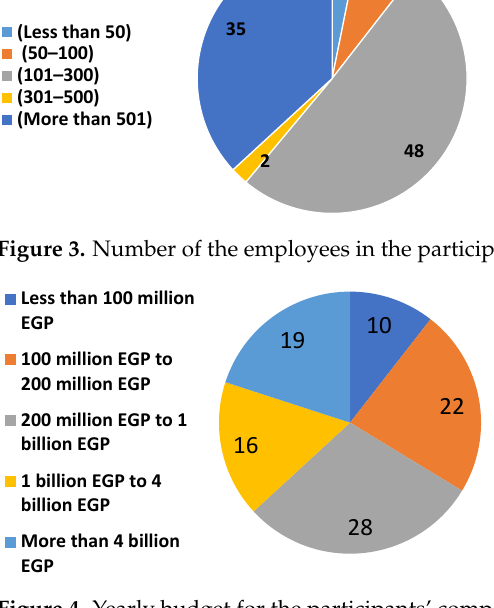
Figure 3. Number of the employees in the participants’ companies .